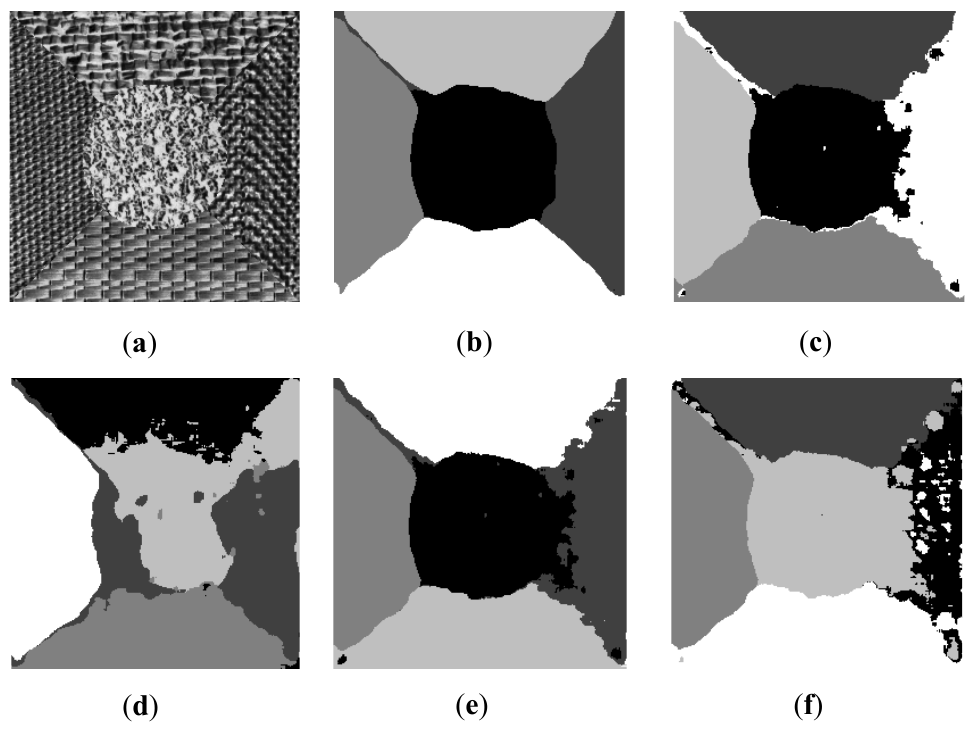
Figure 2. Segmentation results on Image1. ( a ) original image; ( b ) AFWDLMO; ( c ) AFCMOMA;